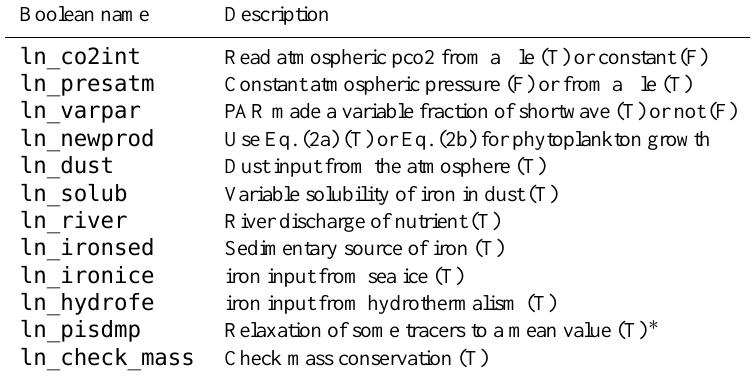
Table 2. Boolean variables in the namelist. These variables activate functionalities of PISCES.